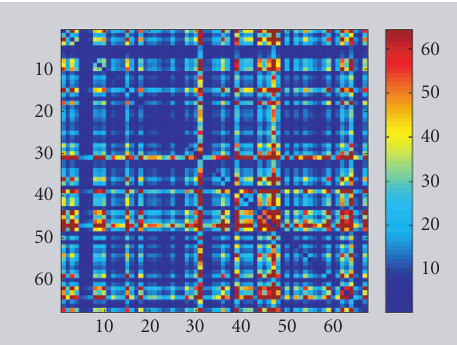
Figure 4. Pattern recognition using dissimilarity matrix δ C . Figure 5. Pattern recognition using δ HZ .